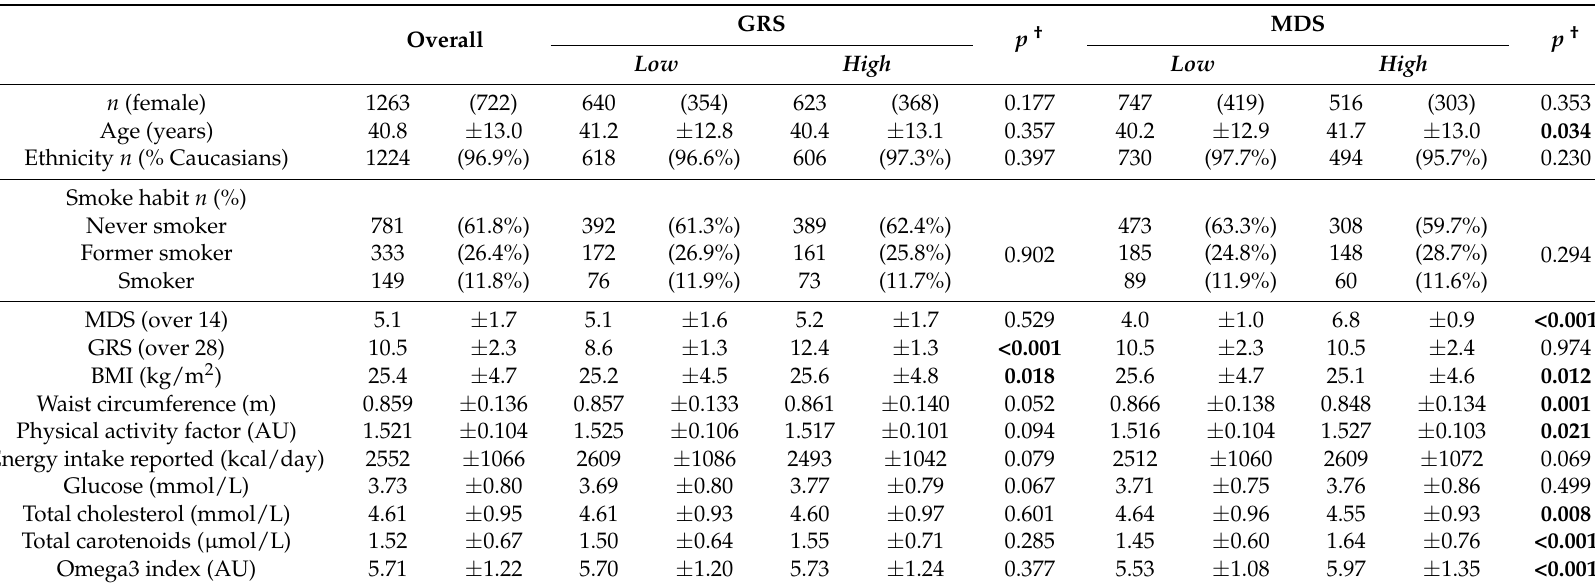
Table 1. Baseline characteristics of the volunteers selected from the Food4Me, and differences between categorized at median GRS and MDS levels ( low score vs. High score)